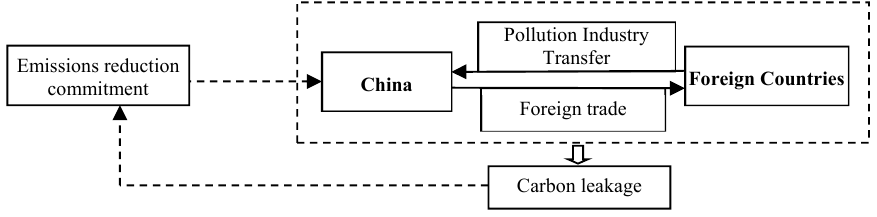
Figure 1. Carbon leakage affects emission reduction commitments.